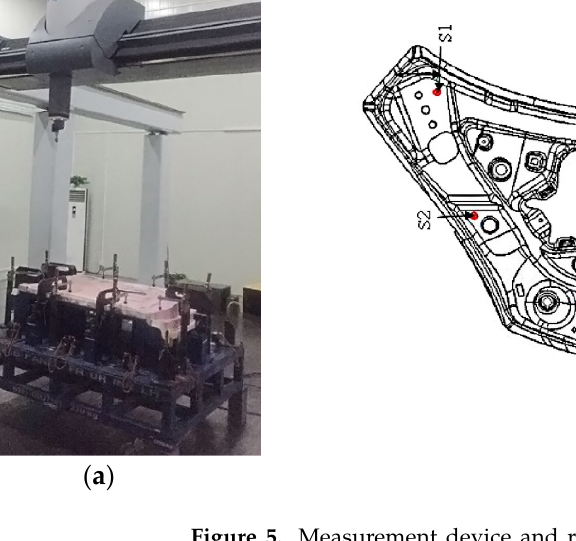
( b ) Figure 5. Measurement device and reference of spring back. ( a ) Three-coordinates measuring ma- chine; ( b ) Measurement reference.